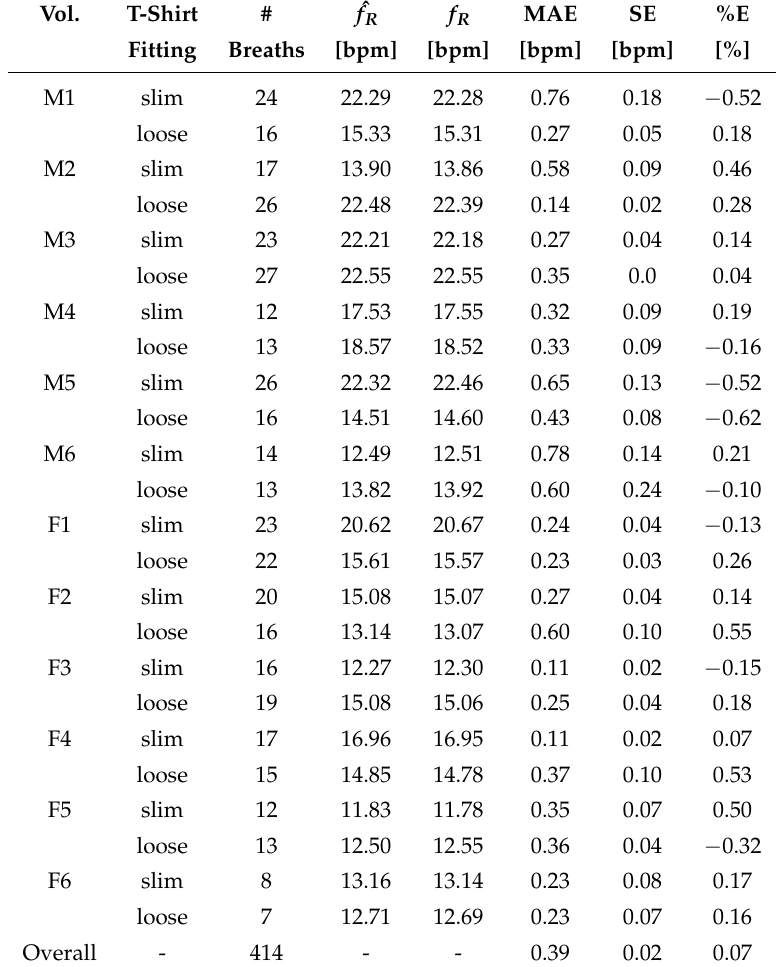
Table 1. Breath-by-breath analysis: average ˆ f R , average f R , mae, se and %e values per each volunteer at the different t-shirt fitting. MAE: Mean Absolute Error ; SE: Standard Error of the mean. Vol. T-Shirt # ˆ f R f R